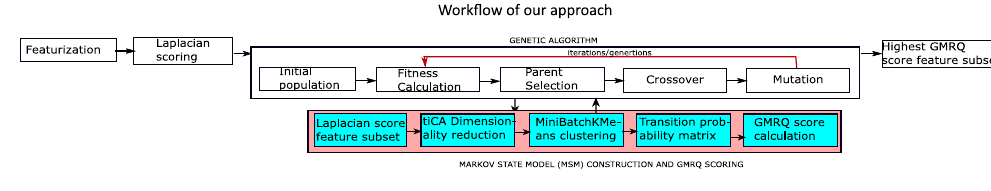
Figure 1 The proposed methodology for the identification of the optimal features. Full-size DOI: